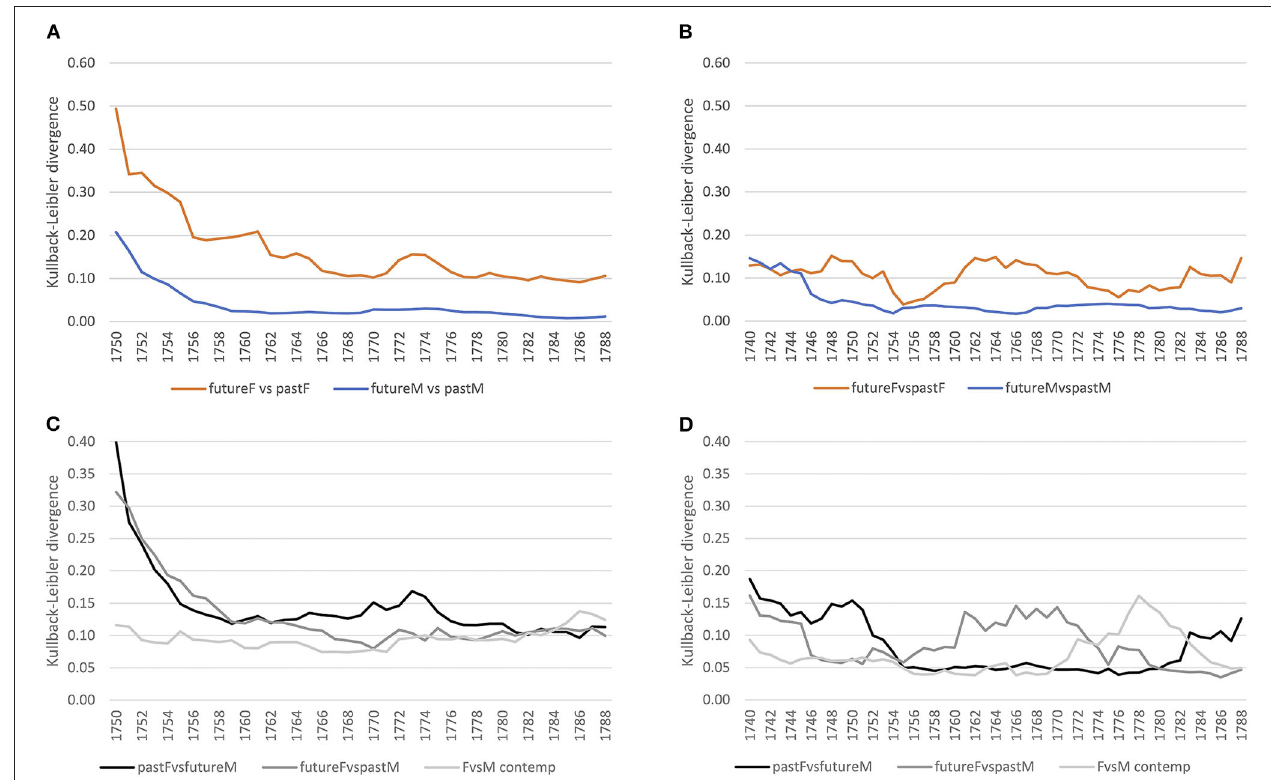
FIGURE 11 | Gender distinguished, diachronic, and contemporary models (court vs. letter) at the morphological level (suffixes). (A) Court: within gender comparison. (B) Letter: within gender comparison. (C) Court: diachronic and contemporary comparison. (D) Letter: diachronic and contemporary comparison.